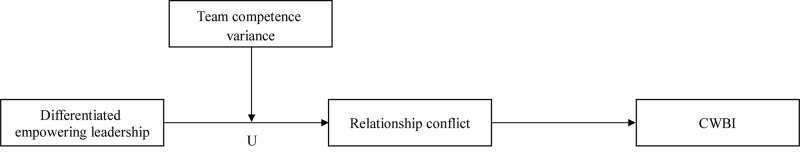
Theoretical model. CWBI is short for counterproductive work behaviors toward individuals.